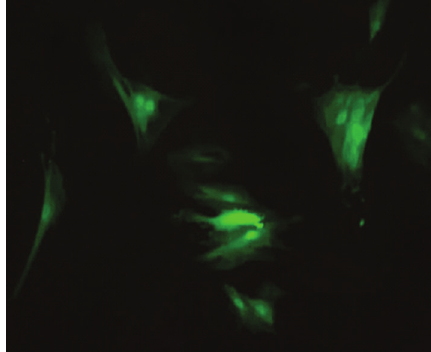
Figure 10: MSCs in multiplicative division emit